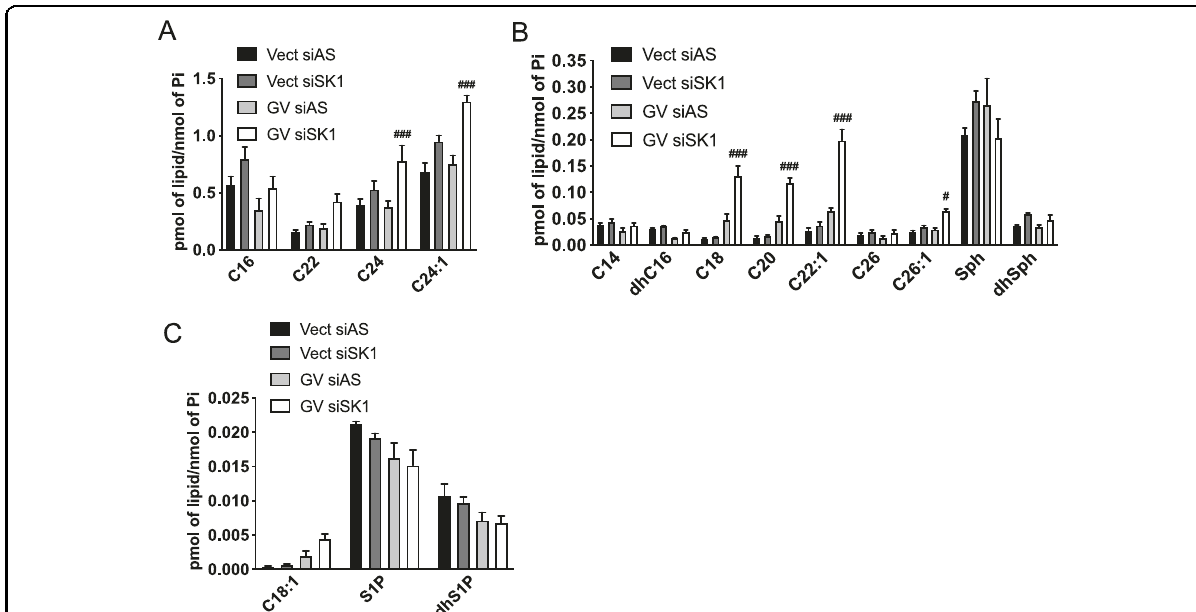
Fig. 7 SK1 downregulation induces an increase of long-chain and very-long-chain Cer, in the context of oncogenic K-Ras overexpression. A – C SL analysis using tandem LC/MS/MS in cells overexpressing Vect or mutant GV K-Ras. Cells were plated and transfected the next day with control (AS) or SK1 siRNA (20 nM) for 72 h and then scraped in a lipid extraction buffer. SL levels were quanti fi ed and normalized to the amount of total lipid phosphate. SL was organized according to their amounts in the cells, from the most abundant in ( A ) to the less abundant in ( C ). Panel B shows the SL having intermediate levels in the cells ( N = 4, data are presented as mean ± SEM, two-way ANOVA with Dunnett ’ s multiple comparisons test, # means p < 0.05 comparing the group GV SK1 siRNA to the group GV control